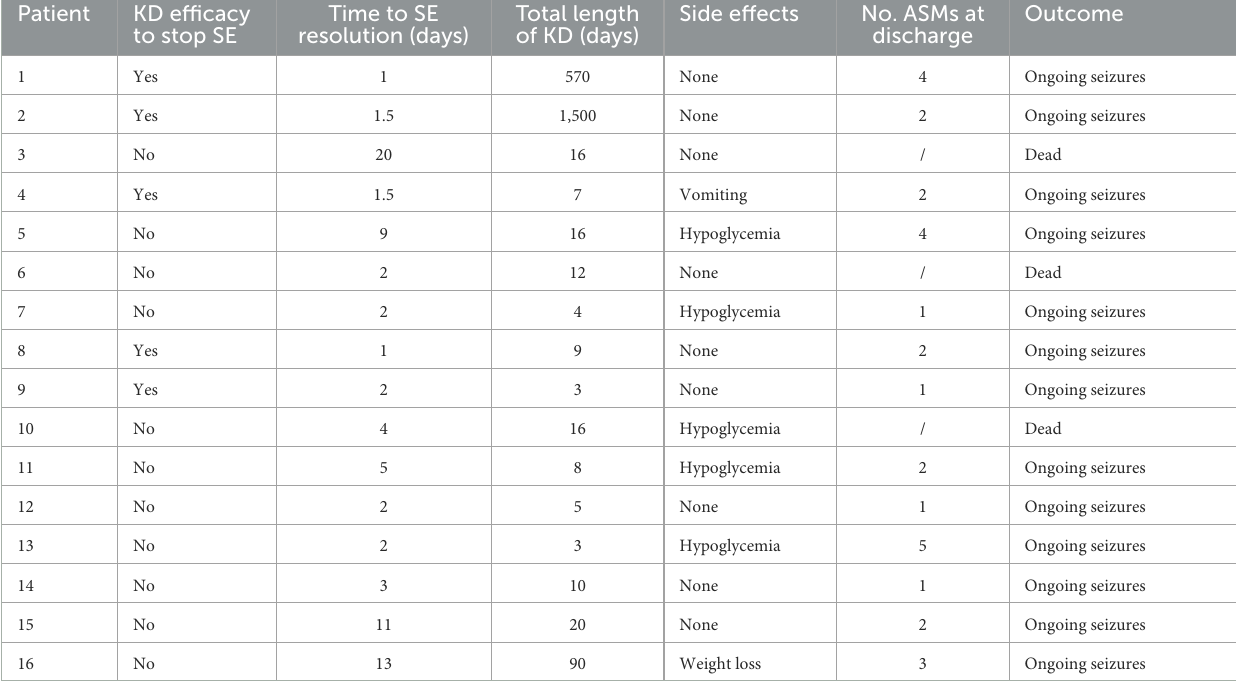
TABLE 2 Necker Enfants Malades Hospital experience: response to KD and outcome.